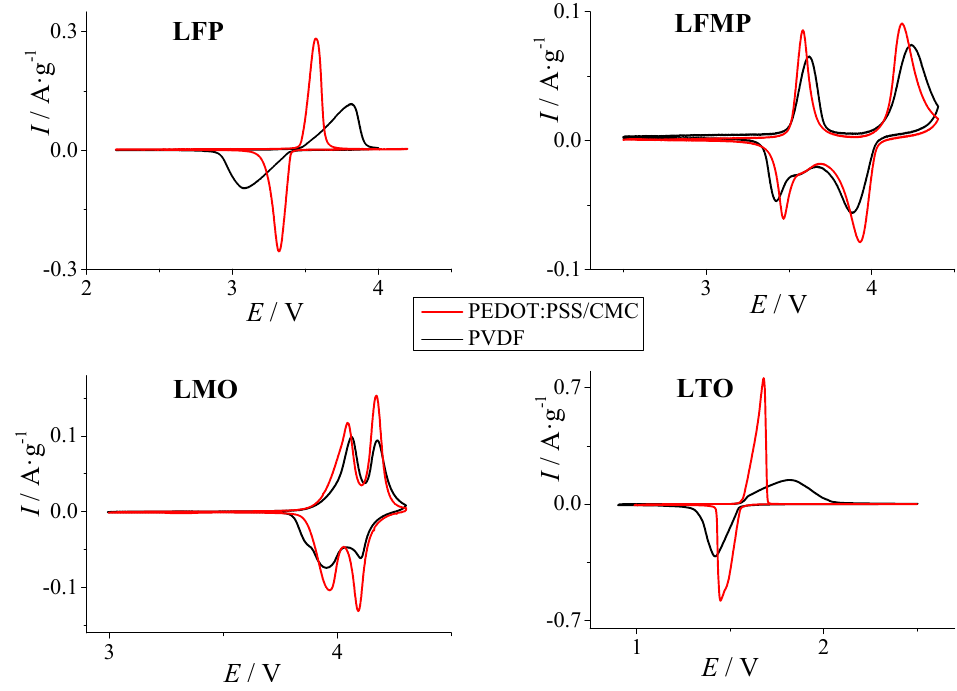
Figure 5. Cyclic voltammograms of freshly prepared LFP, LFMP, LMO, and LTO electrodes with PVDF and PEDOT:PSS/CMC binders at ν = 0.1 mV·s − 1 (3rd cycles presented) (based on our data in Ref. [64–67]).